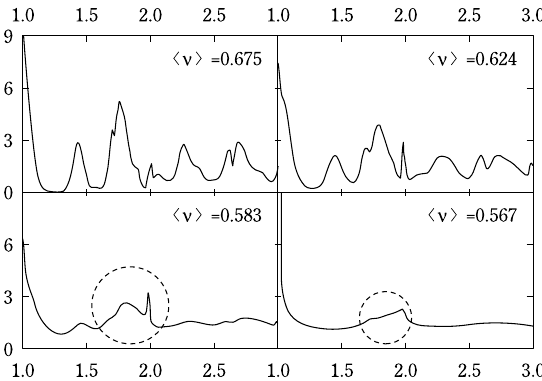
Fig. 12 Radial distribution function for a poured assembly and for vari- ous equilibrium bulk solids fractions ν ∞ with their associated intensities γ shown. The higher ν ∞ results reveal local crystal- line structure, while systems with smaller ν ∞ exhibit features observed in experiments.